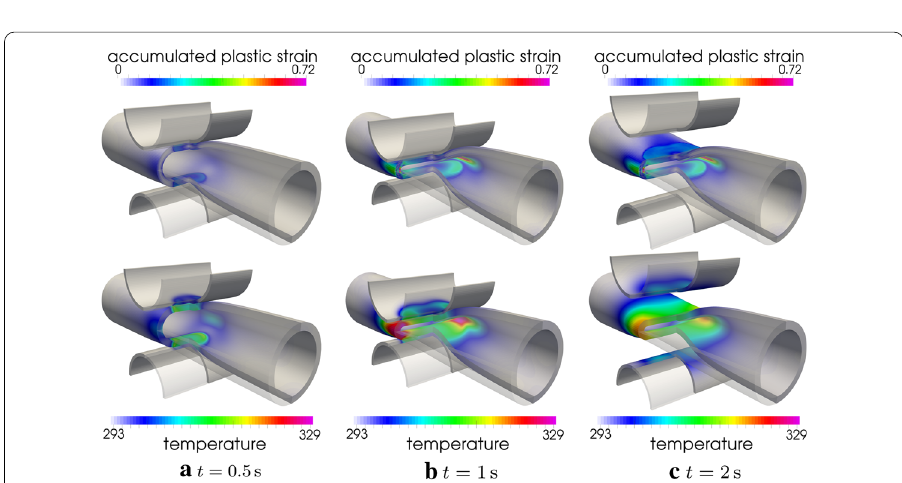
Fig. 10 Squeezed elasto-plastic tube—deformed configurations at different times including accumulated plastic strain and temperature distribution (results of an eighth model reflected for vizualization)